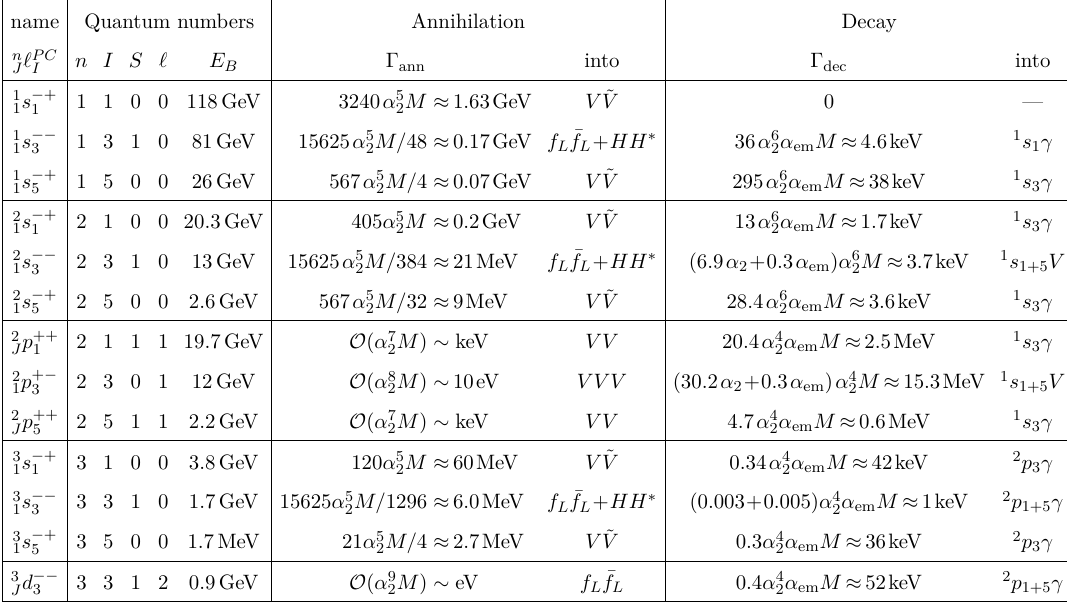
Table 1. Main bound states of fermion weak 5-plets with M ≈ 14TeV . The parity P = ( − 1) ‘ +1 and charge conjugation C = ( − 1) ‘ + S quantum numbers of bound states are broken by chiral weak gauge interactions to SM fermions. Hyper-fine components with different values of J have the same decay rate. Decay rates are not SU(2) -invariant because W,Z emission is sometimes blocked by L phase space; we report decay rates averaged over the weak components of bound